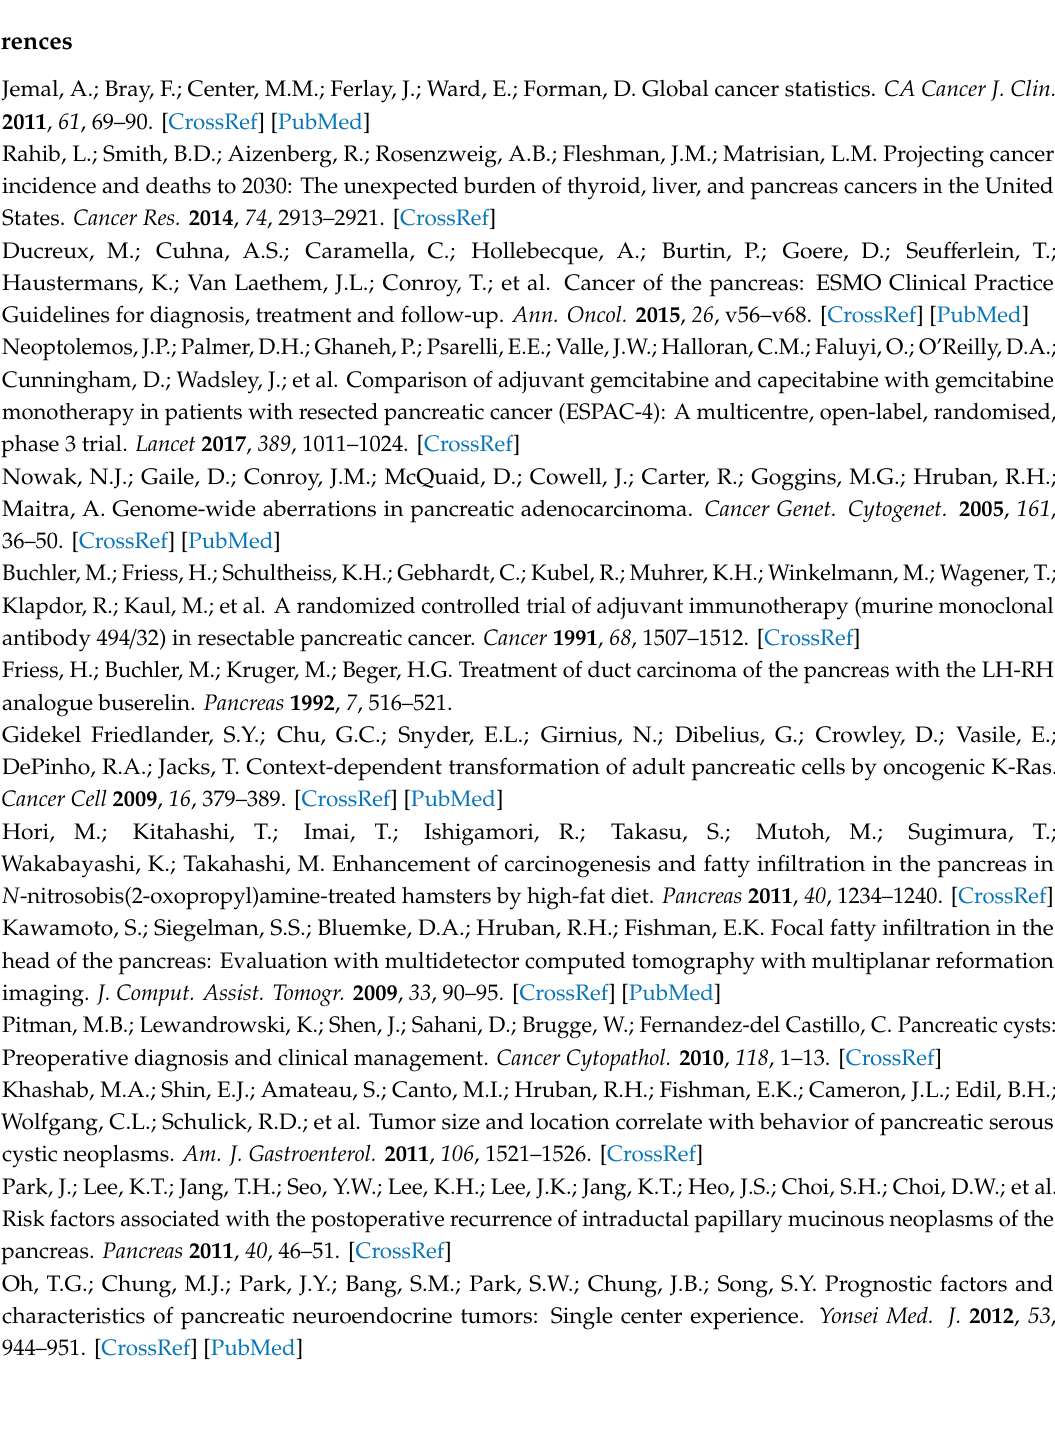
Table S1: List of pancreatic cancer data sets included. Table S2: List of 334 genes di ff erentially expressed between head and B / T location of PDAC. Table S3: Ontology analysis of the 334 genes di ff erentially expressed between the head and B / T location of PDAC. Table S4: Enrichment for cell types and or oncogenic pathway activities in “head” vs. “body / tail” samples. Figure S1. Principal component analysis performed before and after normalization of the 4 data